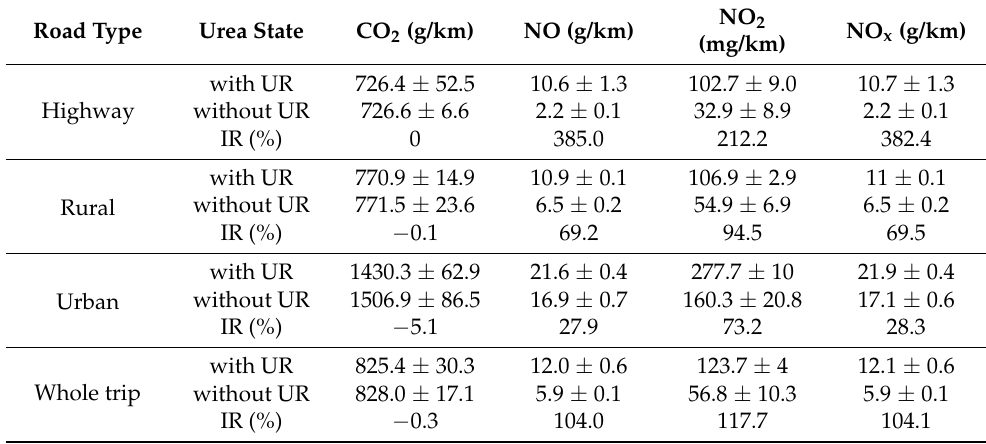
Table 3. On-road nitrogen oxides EFs of the tested truck on different road types. Road